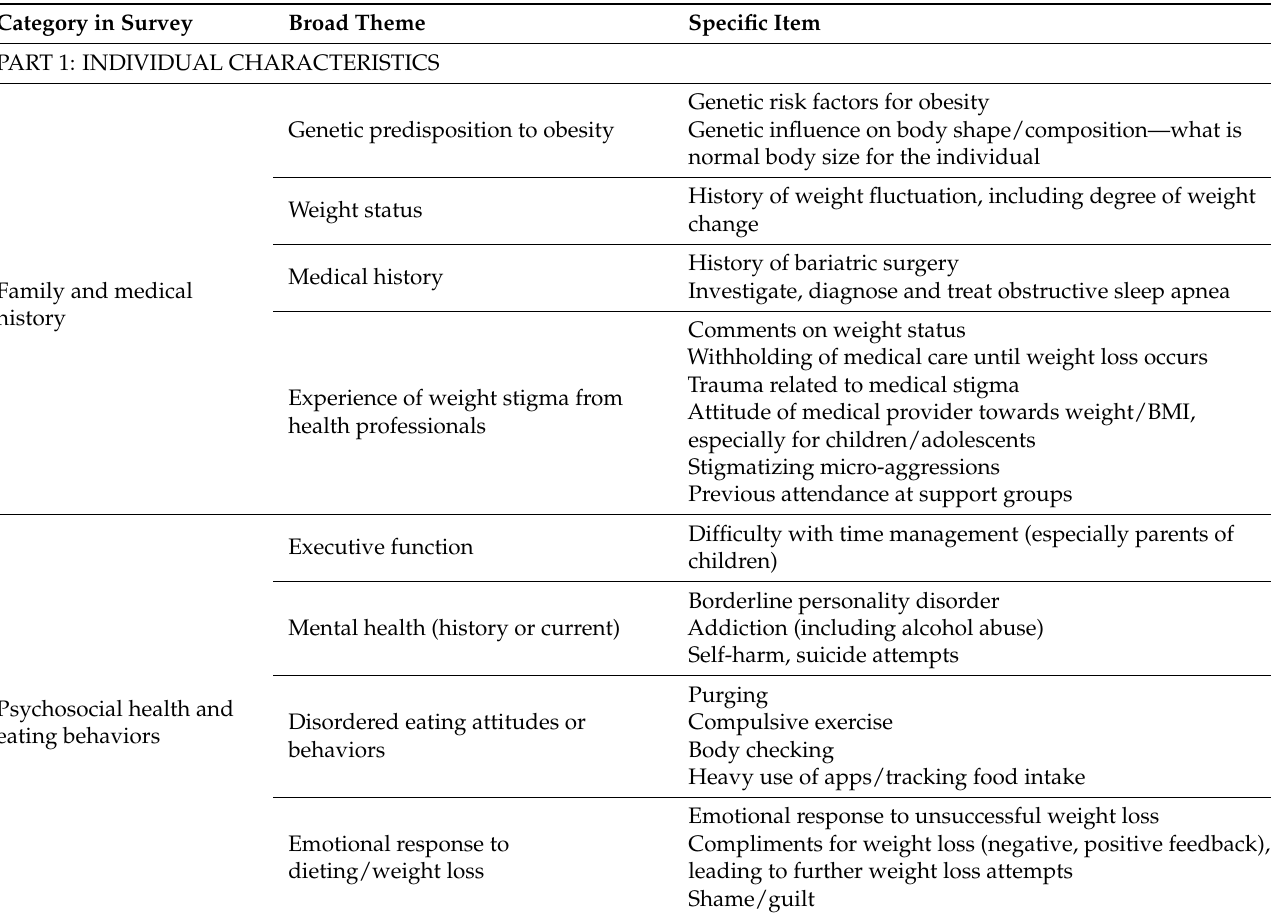
Figure 1. Summary of clusters of individual characteristics (n = 87). Items were rated on a five-point Likert scale from 1 = not relevant at all to 5 = very relevant. See Table S1 for ratings of individual items within each cluster. Table 2. Additional items suggested as being relevant to eating disorder risk in the context of weight